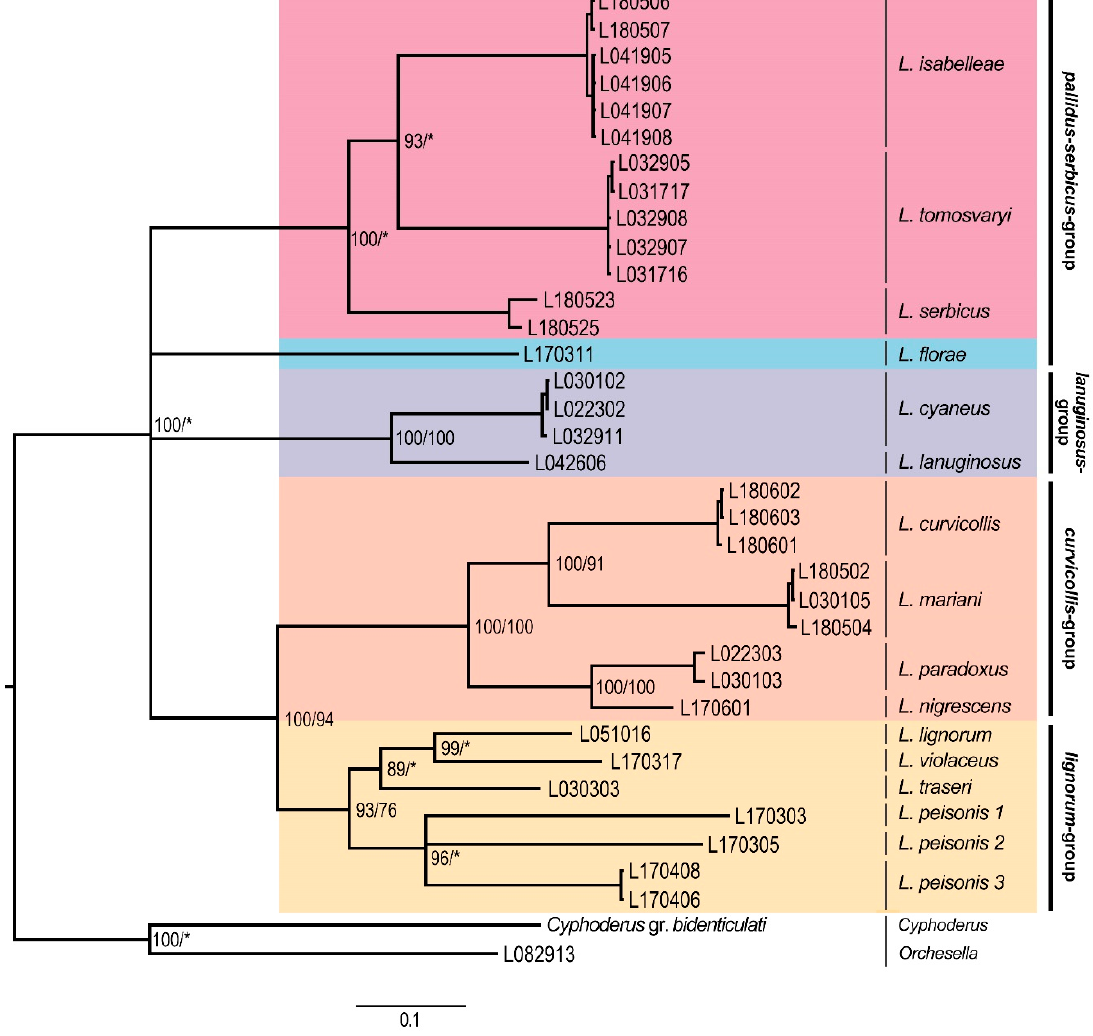
Figure 1. Bayesian consensus tree based on the concatenated (COII and EF1- α ) dataset. Numbers close to nodes denote Bayesian posterior probabilities (BI) / maximum likelihood (ML) bootstrap support. Asterisks (*) indicate posterior probabilities or bootstrap values less than 60%. Morphological groups are labeled in bold.